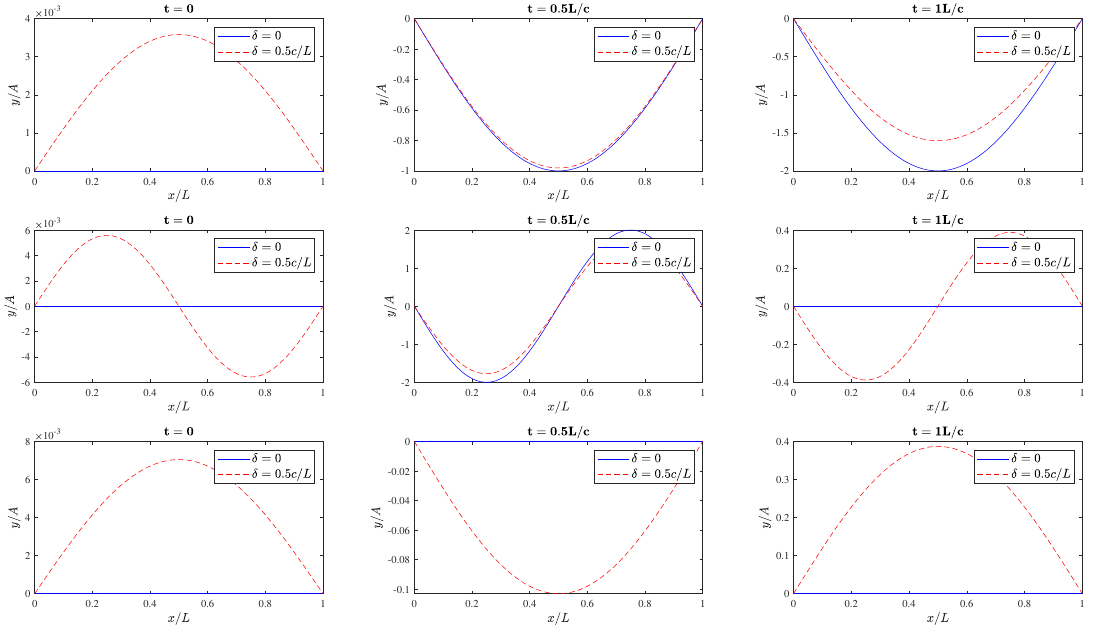
Figure 5. Total non-resonant oscillations with forcing, canceling the initial free oscillation at time zero at three distinct times. The blue solid lines correspond to no damping, δ = 0, whereas the red dashed lines correspond to oscillations with damping, δ = 0.5 c / L . Each row corresponds to a distinct set of values of the mode of oscillation n (which influences the values of spatial wavenumber k and free oscillation ˜ ω ) and ω : the upper row is for { n , ω } = { 1,4 π c / L } , the middle row is for { n , ω } = { 2,4 π c / L } , and the bottom row is for { n , ω } = { 1,3 π c / L } . In all the cases, the wavenum- ber is related to n by k = n π / L . The plots are obtained for α = 0 = β